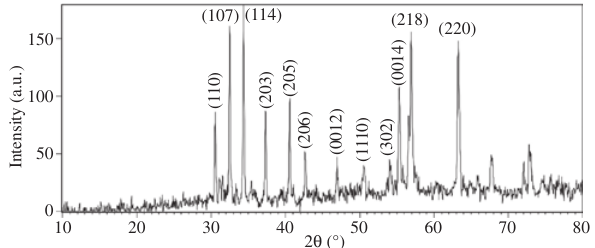
O nanoparticles. 12 19